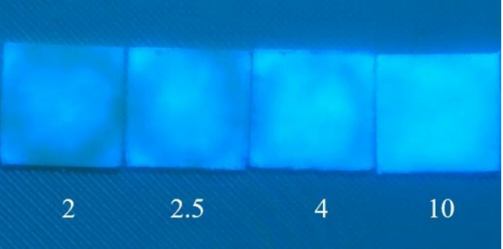
Figure 14. PAD after adding the honeysuckle extract. The numbers in the figure are the dilution times of the added honeysuckle extract.